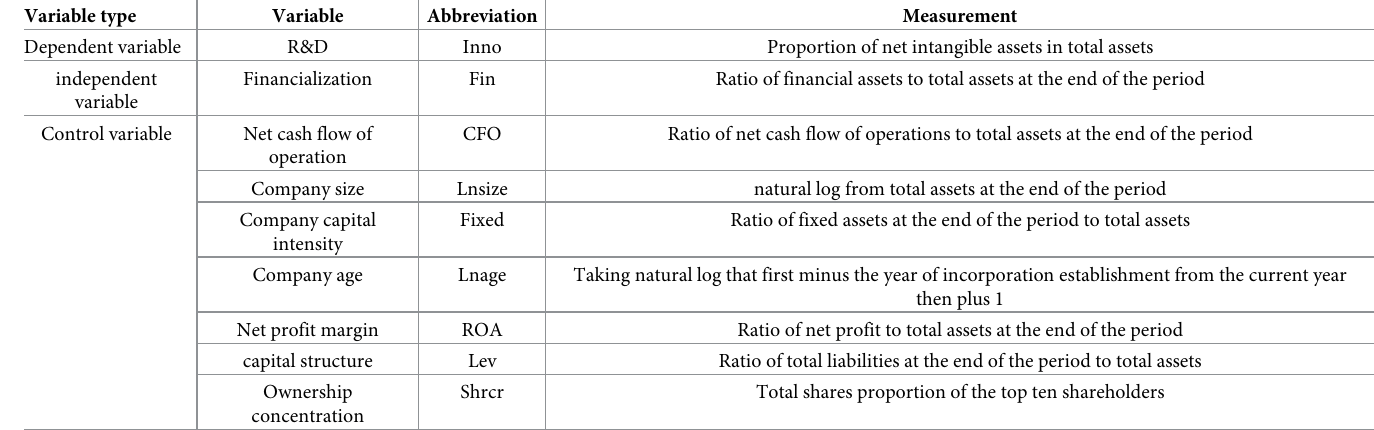
Table 1. Variables